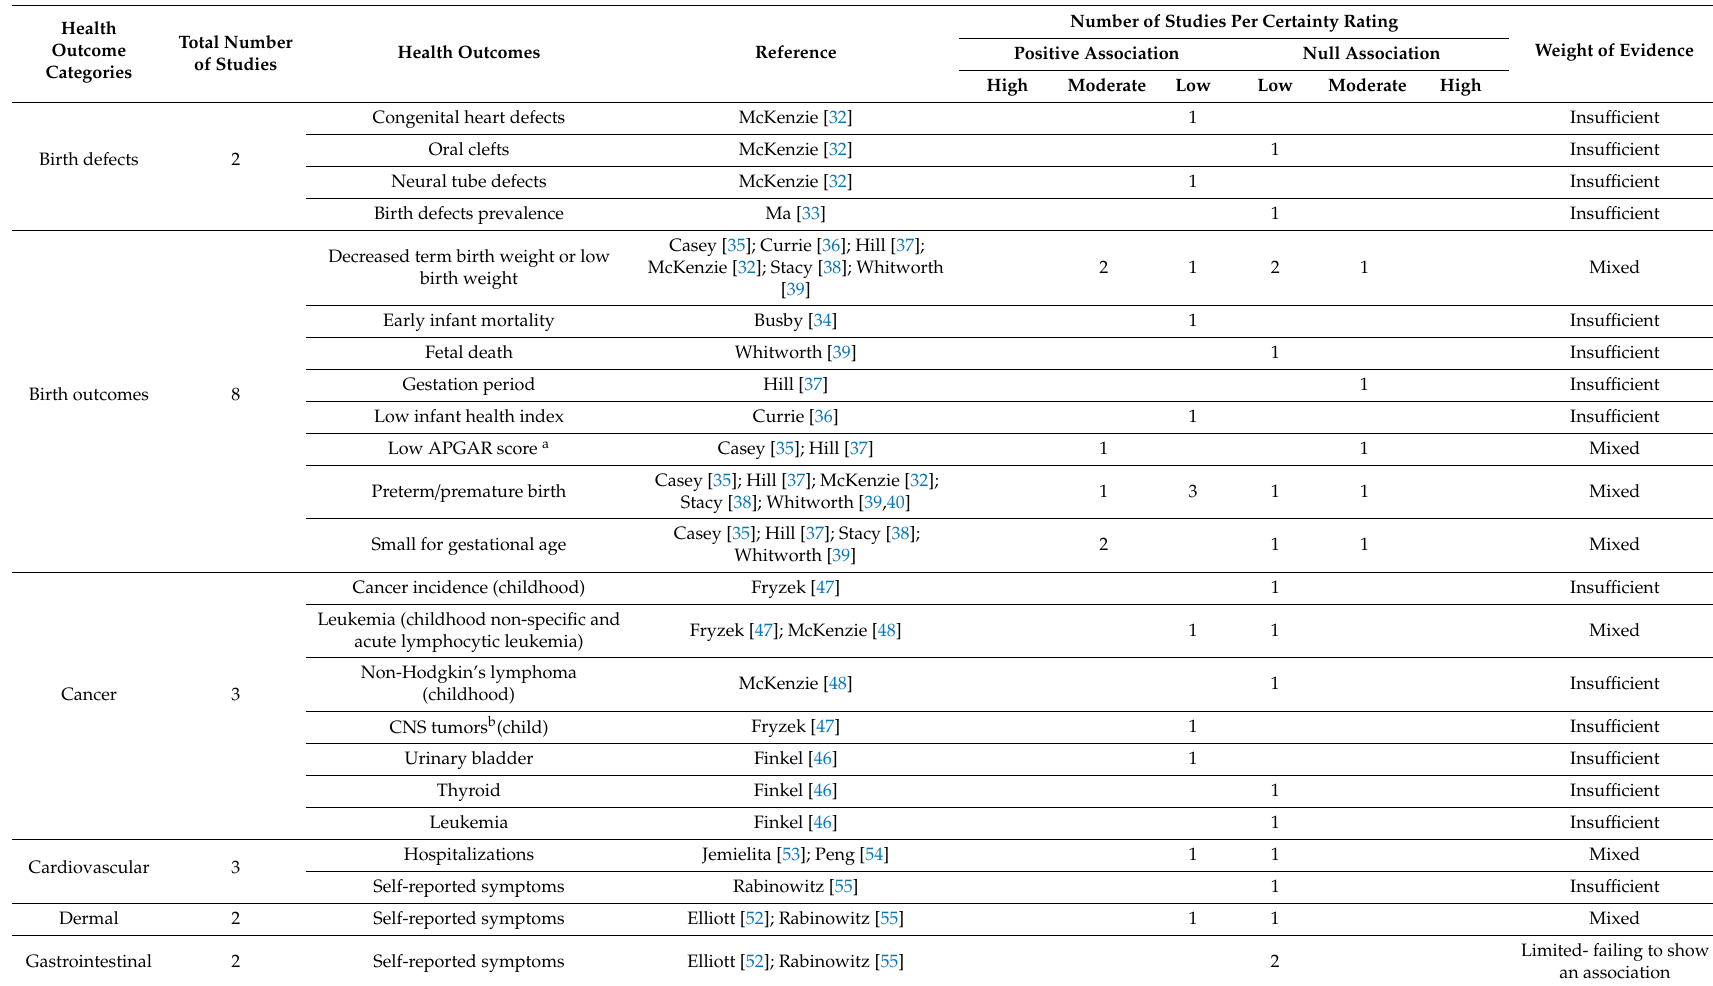
Table 4. Summary of the overall weight-of-evidence determinations for each health